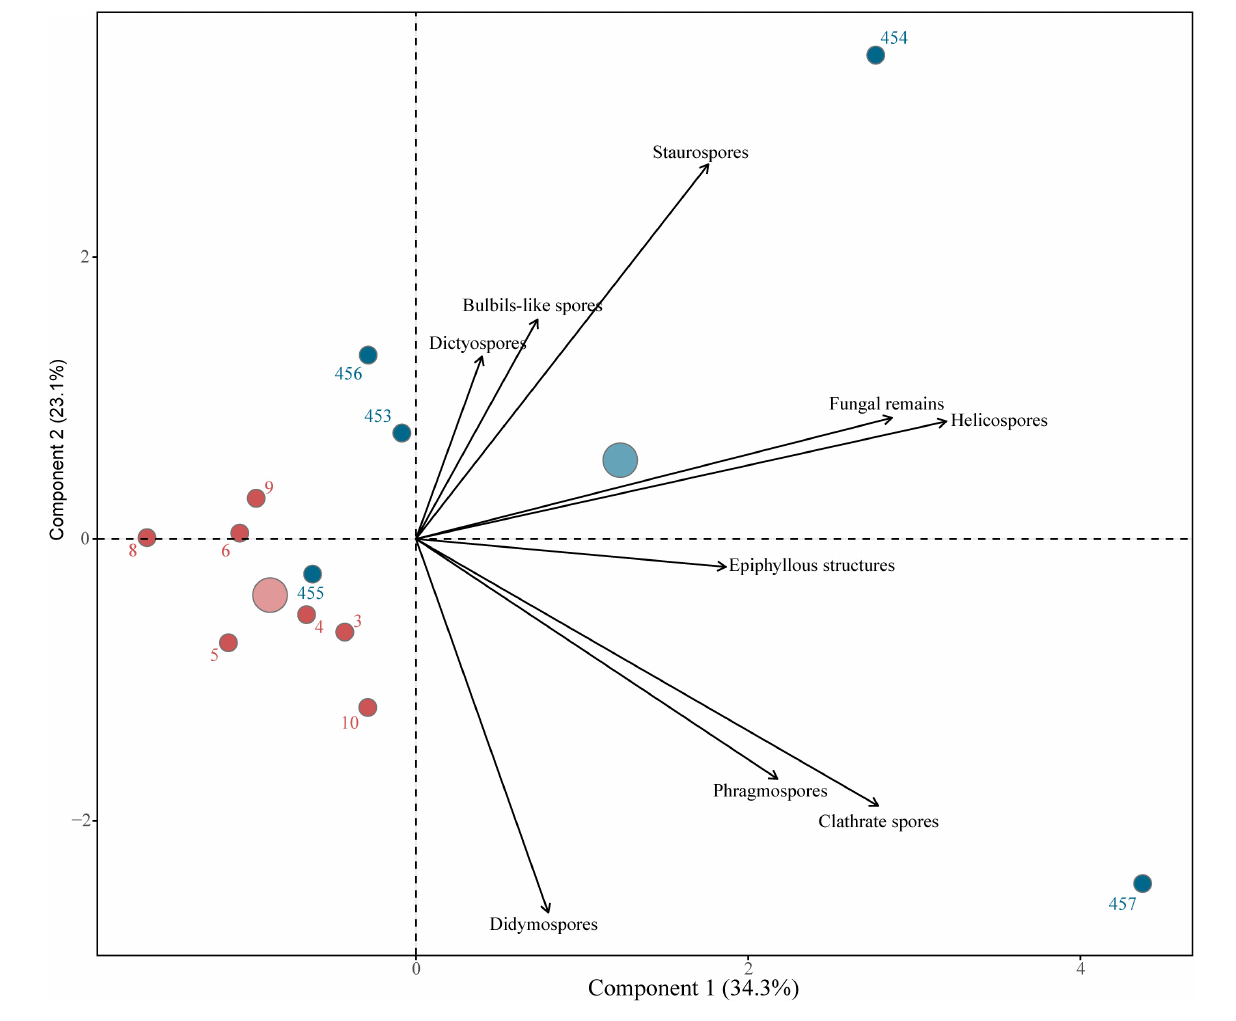
FIGURE 9 | Principal component analysis, without including amerospores, compares the variation between and within samples from Thailand and Slovakia. Big circles indicate the midpoint of each group of samples, separating Thailand (blue) and Slovakia